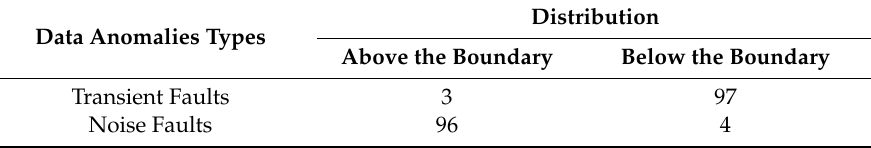
Figure 11. The distribution of transient faults and noise faults. Table 5. The distribution of transient faults and noise faults.